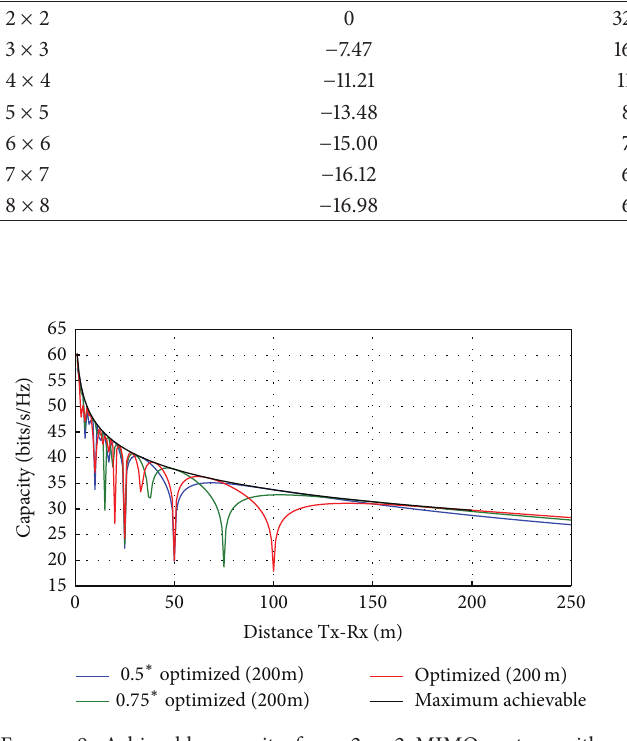
Figure10:Achievablecapacityfor2 × 2,3 × 3,4 × 4,and5 × 5MIMO with reduced subarray